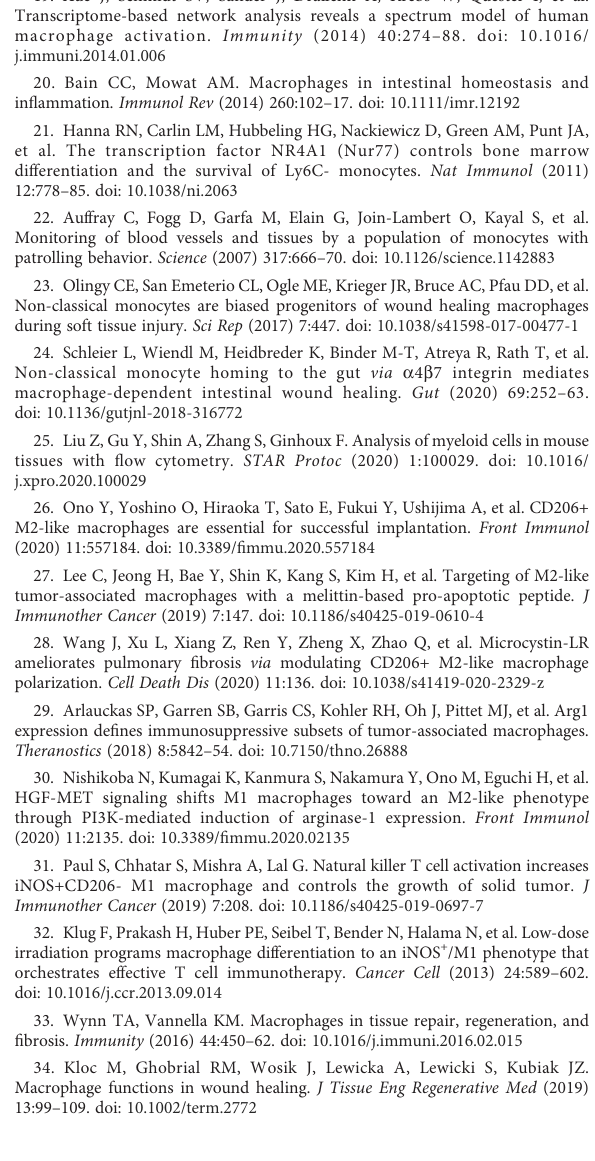
SUPPLEMENTARY FIGURE 1 (A – C) Quantitative analyses of the Cd45 + Cd172a + Cd11b + parent population of the bone marrow (A) , spleen (B) and peripheral blood (C) in Nr4a1 -/- (n=7-8) and WT (n=7-9) mice underlying Figure 1. (D – F) Quantitative fl ow cytometry analyses of SiglecF + Ly6G - (left) and SiglecF - Ly6G + cells (right) in the bone marrow (D) , spleen (E) and peripheral blood (F) (n=6-9). (G) Representative gating for the identi fi cation of Ly6C hi and Ly6C low monocyte subsets in the bone marrow of Nr4a1 -/- and WT mice (H) Quantitative analysis of Ly6C hi and Ly6C low monocytes in the lamina propria of Nr4a1 -/- (n=7) and WT mice (n=6). * p < 0.05.